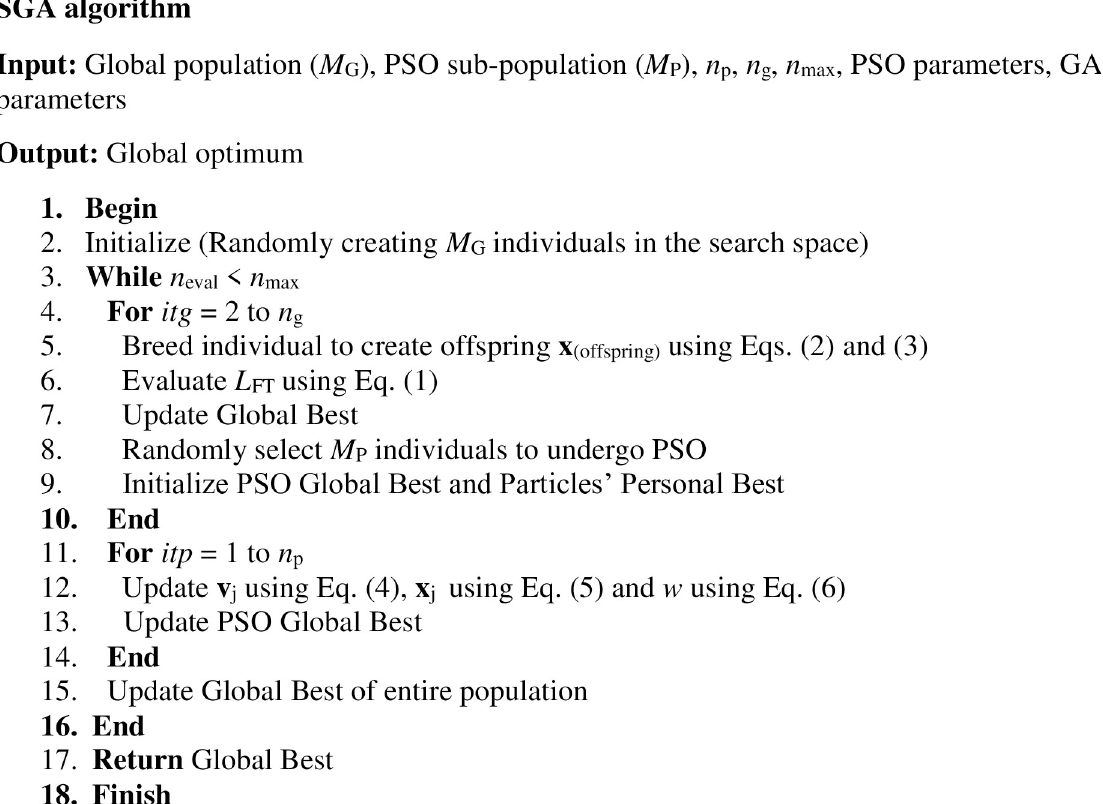
Fig 7. Pseudocode of the proposed hybrid